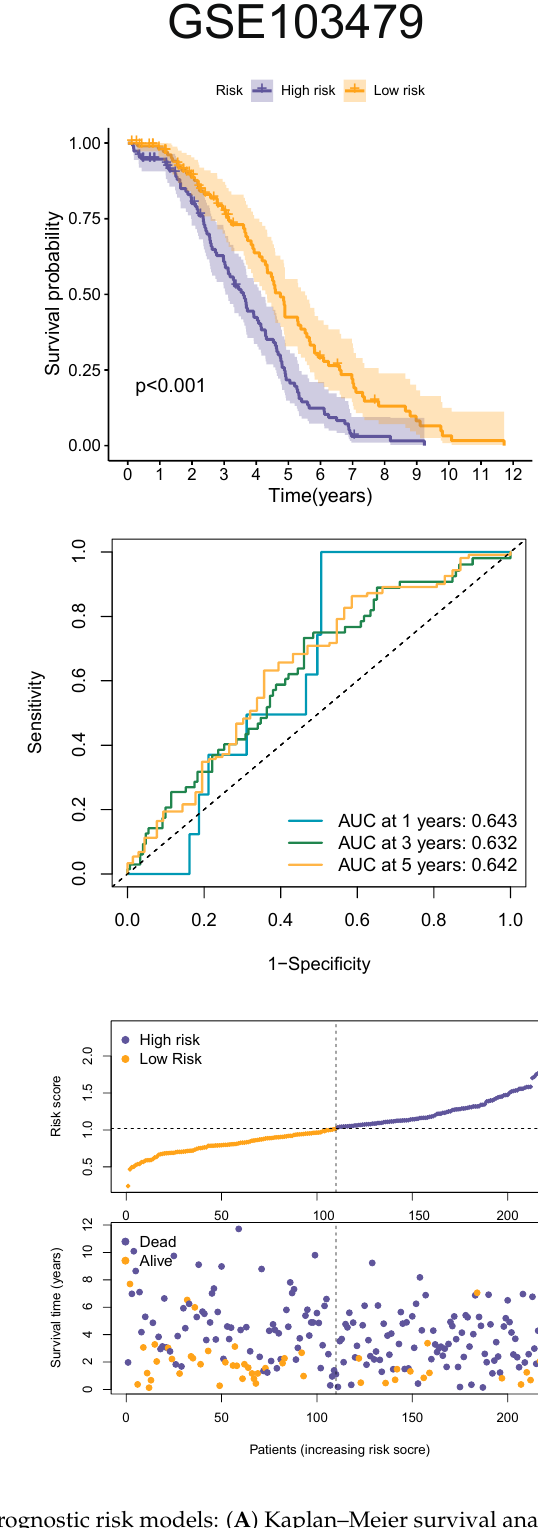
Figure 4. External validation of prognostic risk models: ( A ) Kaplan–Meier survival analysis of OS between patients with high-risk scores and low-risk scores in the GSE14333 and GSE103479 cohorts. ( B ) ROC analysis of the prognostic model in the GSE14333 and GSE103479. ( C ) risk score and survival status in the GSE14333 and GSE103479